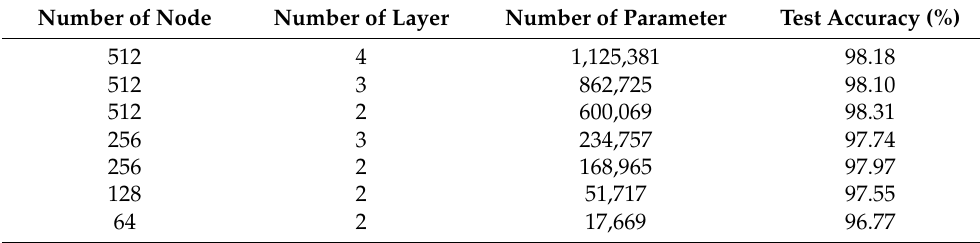
Table 5. Fault detection accuracy according to network size for